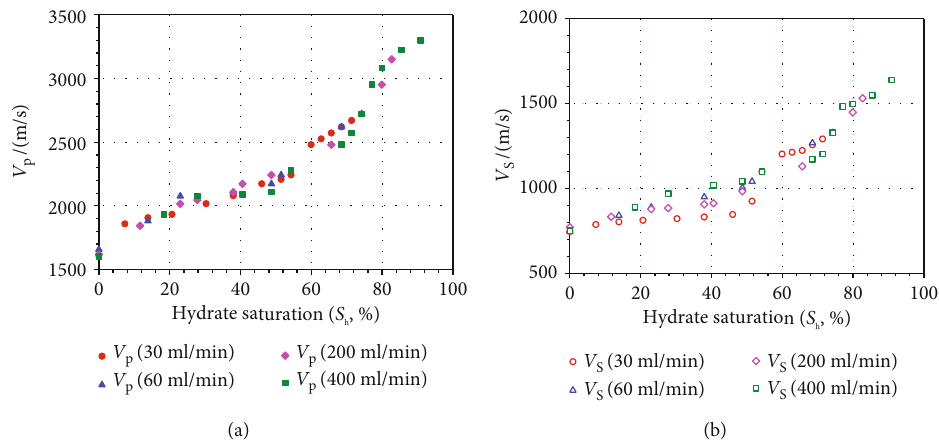
Figure 7: Variation in wave velocities with hydrate saturation in di ff erent methane fl ux. (a) Variation of P-wave velocity. (b) Variation of S- wave velocity (Data for Figure 7 are in Table S7 in the Supplementary